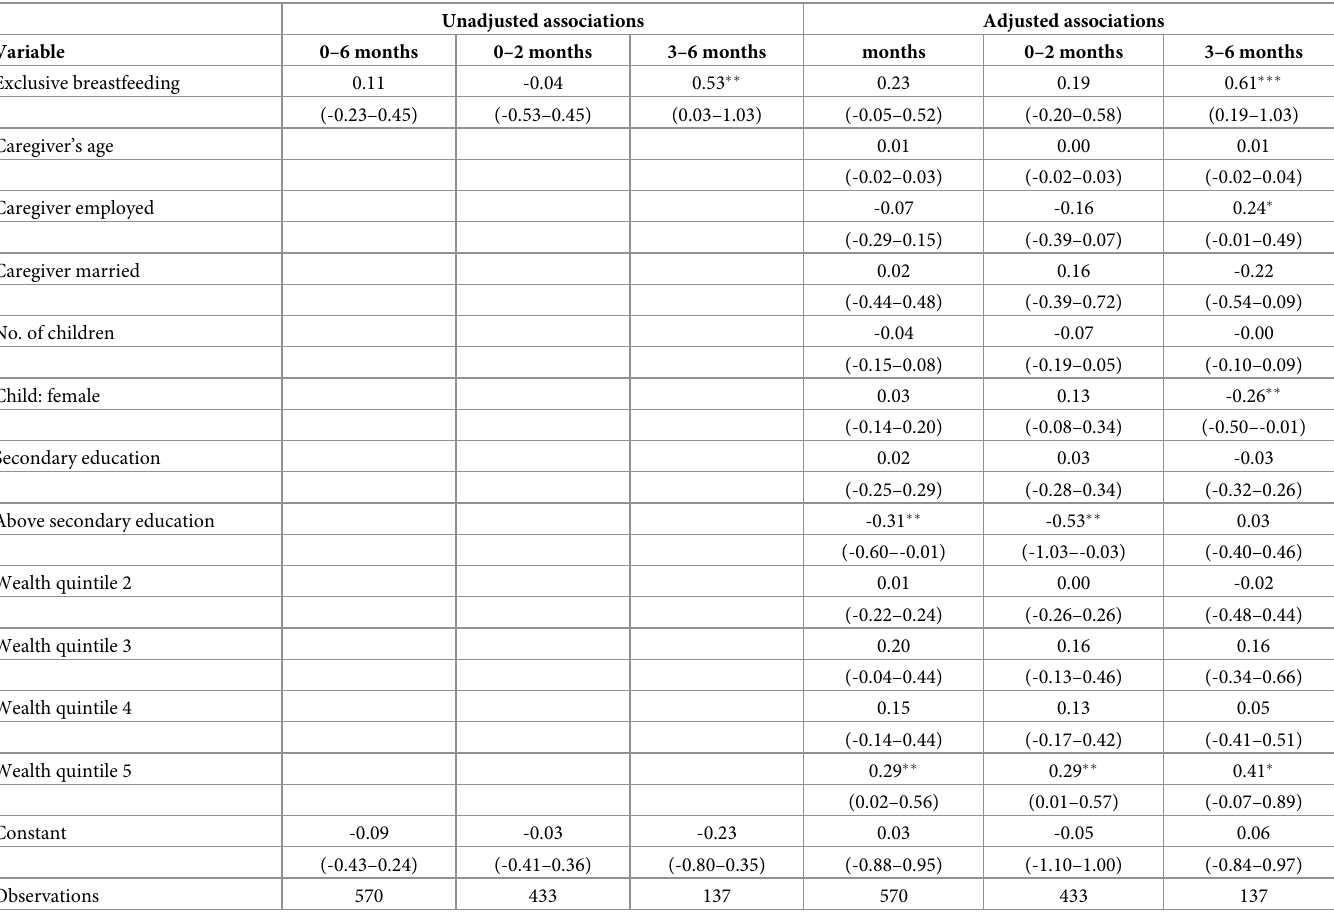
Table 3. Unadjusted and adjusted regression for the associations between current EBF and child development (ASQ scores) ages 0–6 months.